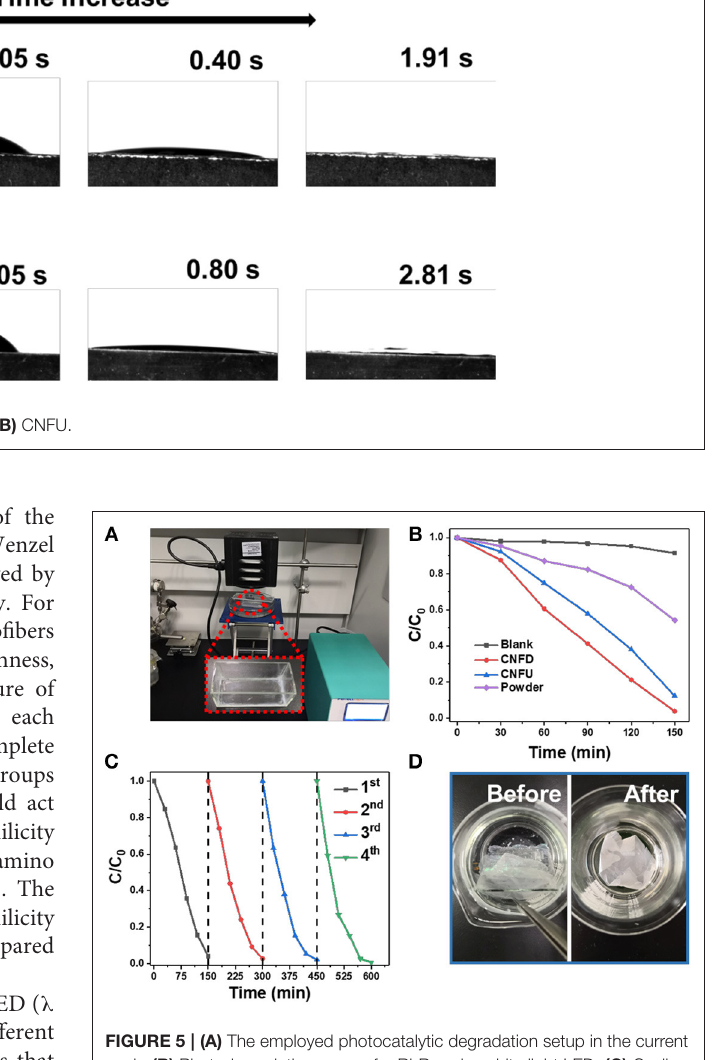
FIGURE 5 | (A) The employed photocatalytic degradation setup in the current work. (B) Photodegradation curves for RhB under white light LED. (C) Cyclic degradation experiments for CNFD under white light LED. (D) Digital photos of CNFD before (left) and after (right) four consecutive